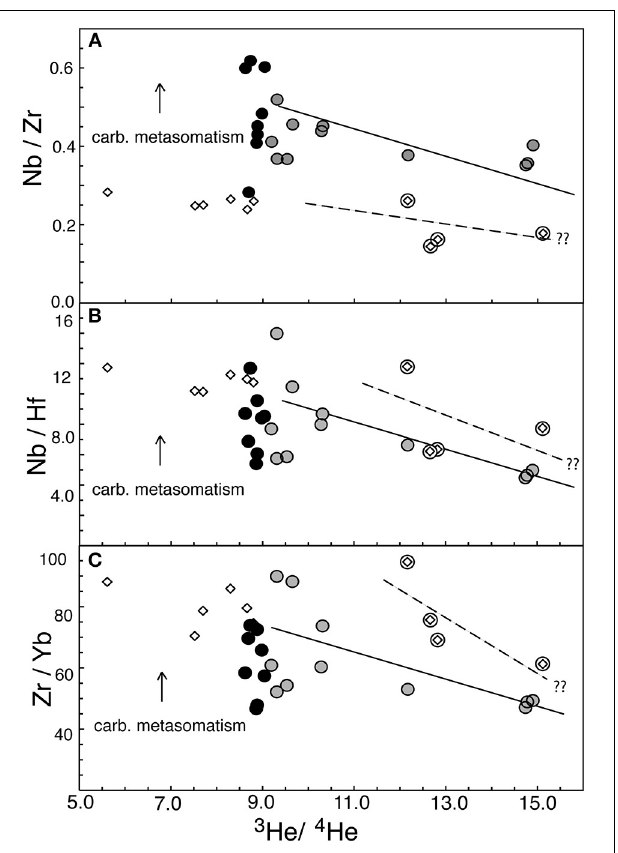
FIGURE 7 | Variations of (A) Nb/Zr, (B) Nb/Hf, and (C) Zr/Yb against 3 He/ 4 He for RVP and MER samples. (Symbols as in Figure 2 ) High 3 He/ 4 He ( > 9 R A —gray circle for RVP; circled diamond for MER) lavas from RVP and MER appear to merge to ∼ common values, which we propose as plume V. The compositional variabilities in the bulk of RVP and MER lavas are due to differences in basement lithologies (see Figure 1 ) and effect